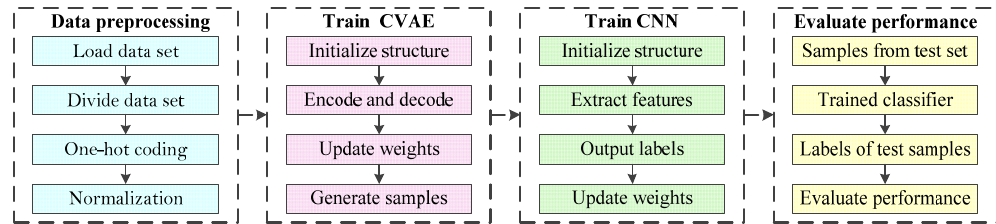
Figure 3. Process of electricity theft detection based on data augmentation.